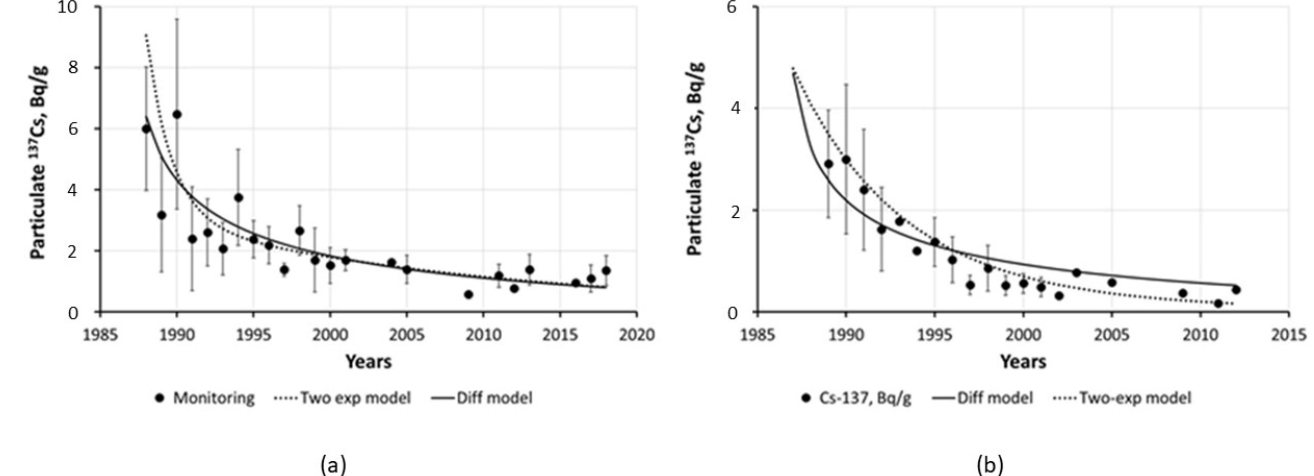
Figure 5. Time dependence of annual mean particulate 137 Cs activity concentrations (black circles) in 1989–2018 for Pripyat River at Chernobyl ( a ) and in 1989–2012 for Dneper River at Nedanchichi ( b ) against approximations by Equation (13) (solid line) and by two-exponential Equation (12) with parameters from Table 3 (dotted line) [102]. Reprinted/adapted with permission from Ref. [102].